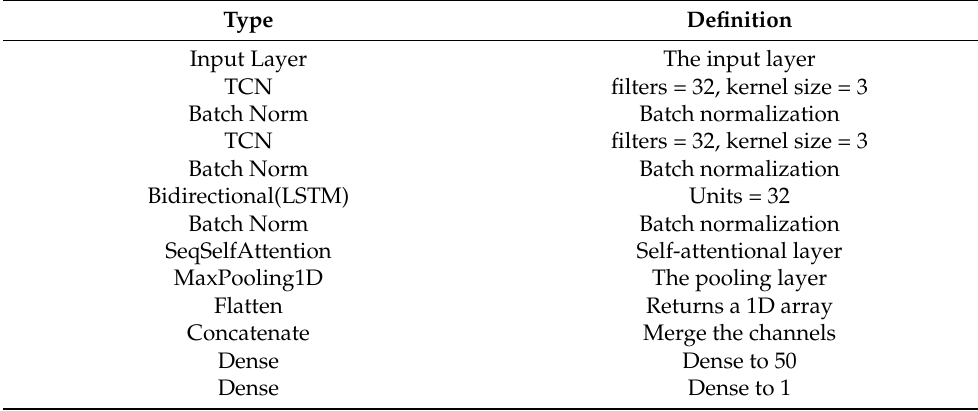
Table 1. Network parameters based on TCN-BILSTM and multi-head attention.